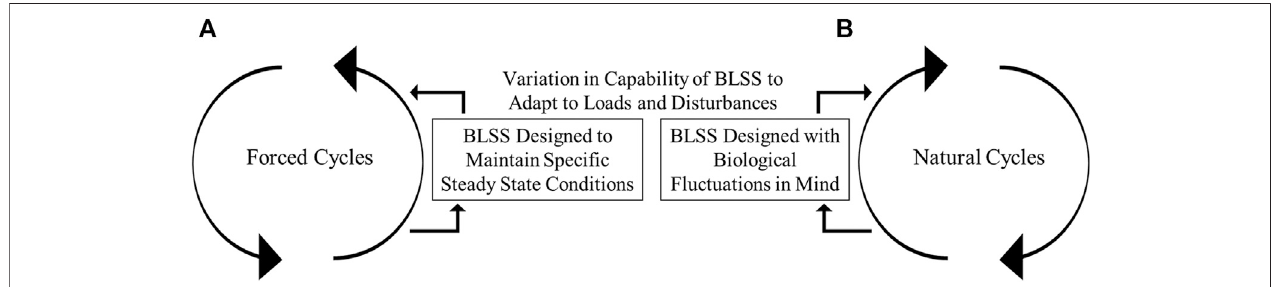
FIGURE 1| Adaptability of bioregenerative life support systems (BLSS) in forced and natural cycles. (A) Approach in which a bioregenerative life support system is designed within engineered system processes and are expected to meet speci fi c steady state parameters through forced cycle management. (B) Approach in which a bioregenerative life support system is designed within natural cycles with minimal to no forced cycle management.